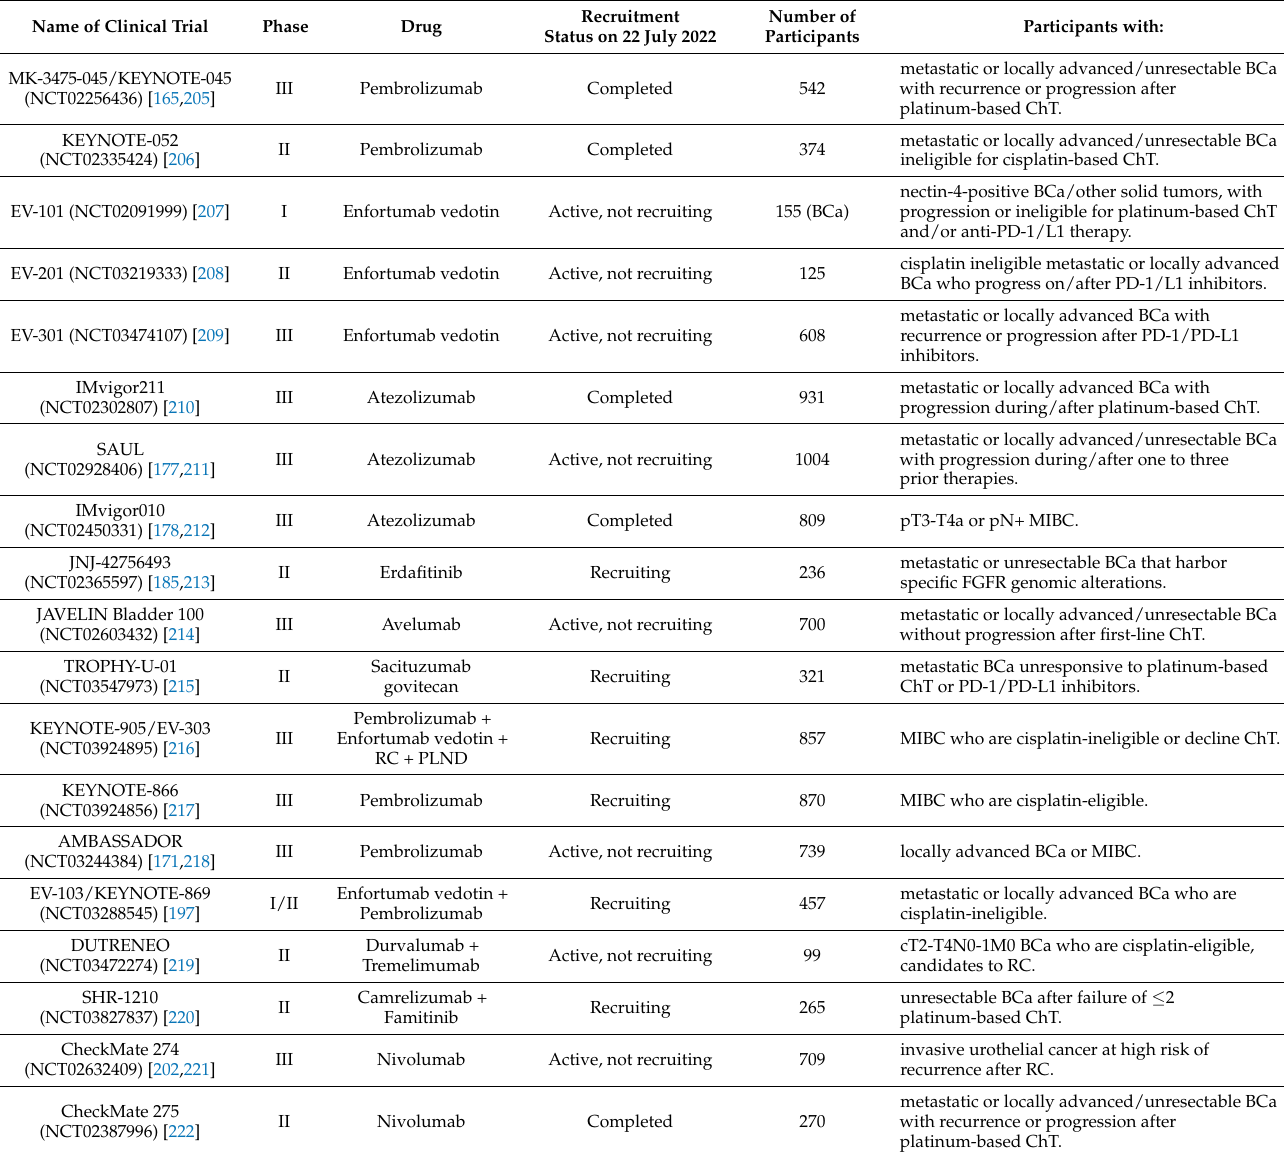
Table 4. Currently ongoing clinical trials on immunotherapy in